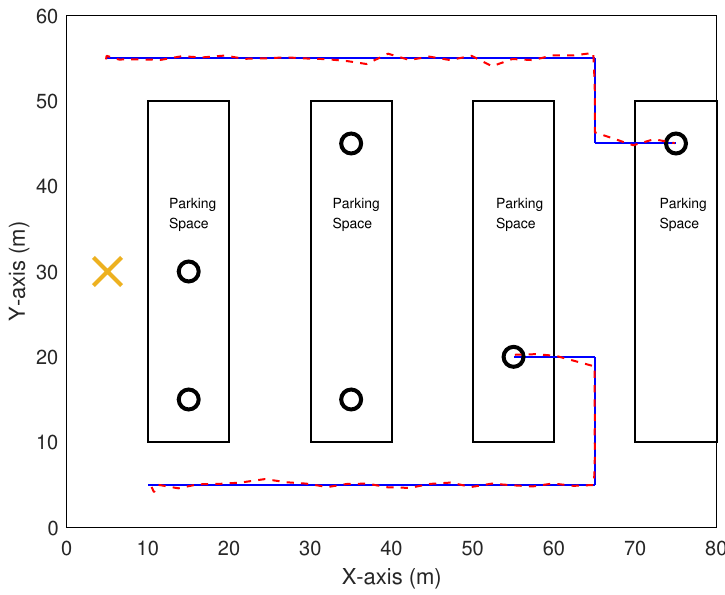
Figure 8. Trajectory of vehicles in an urban